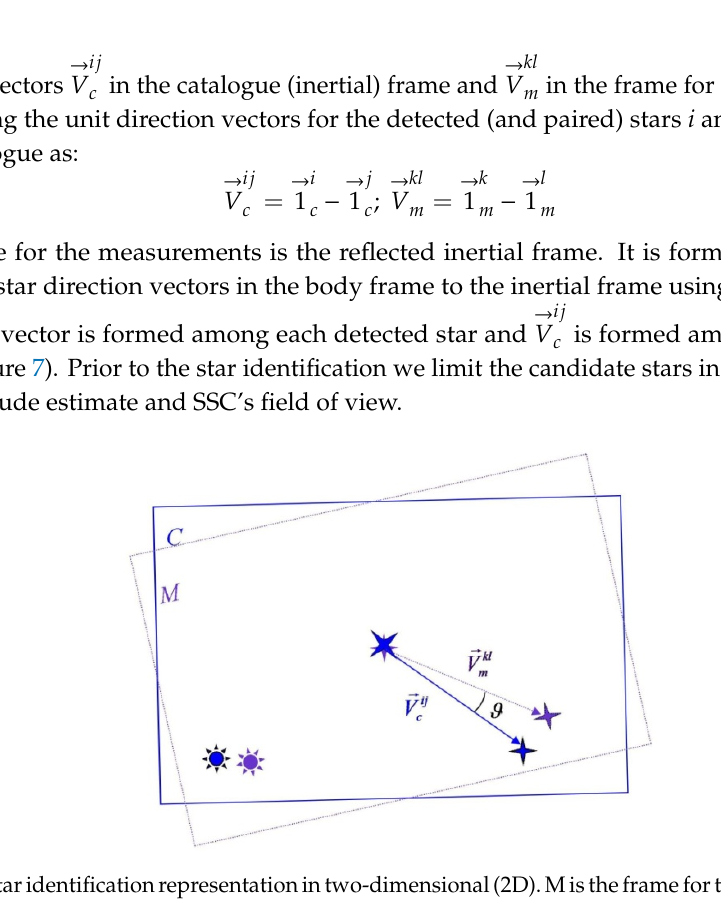
Figure7. Staridentificationrepresentationintwo-dimensional(2D).Mistheframeforthemeasurements Figure 7. Star identification representation in two-dimensional (2D). M is the frame for the and C is the catalogue (inertial) measurements and C is the catalogue (inertial) frame.